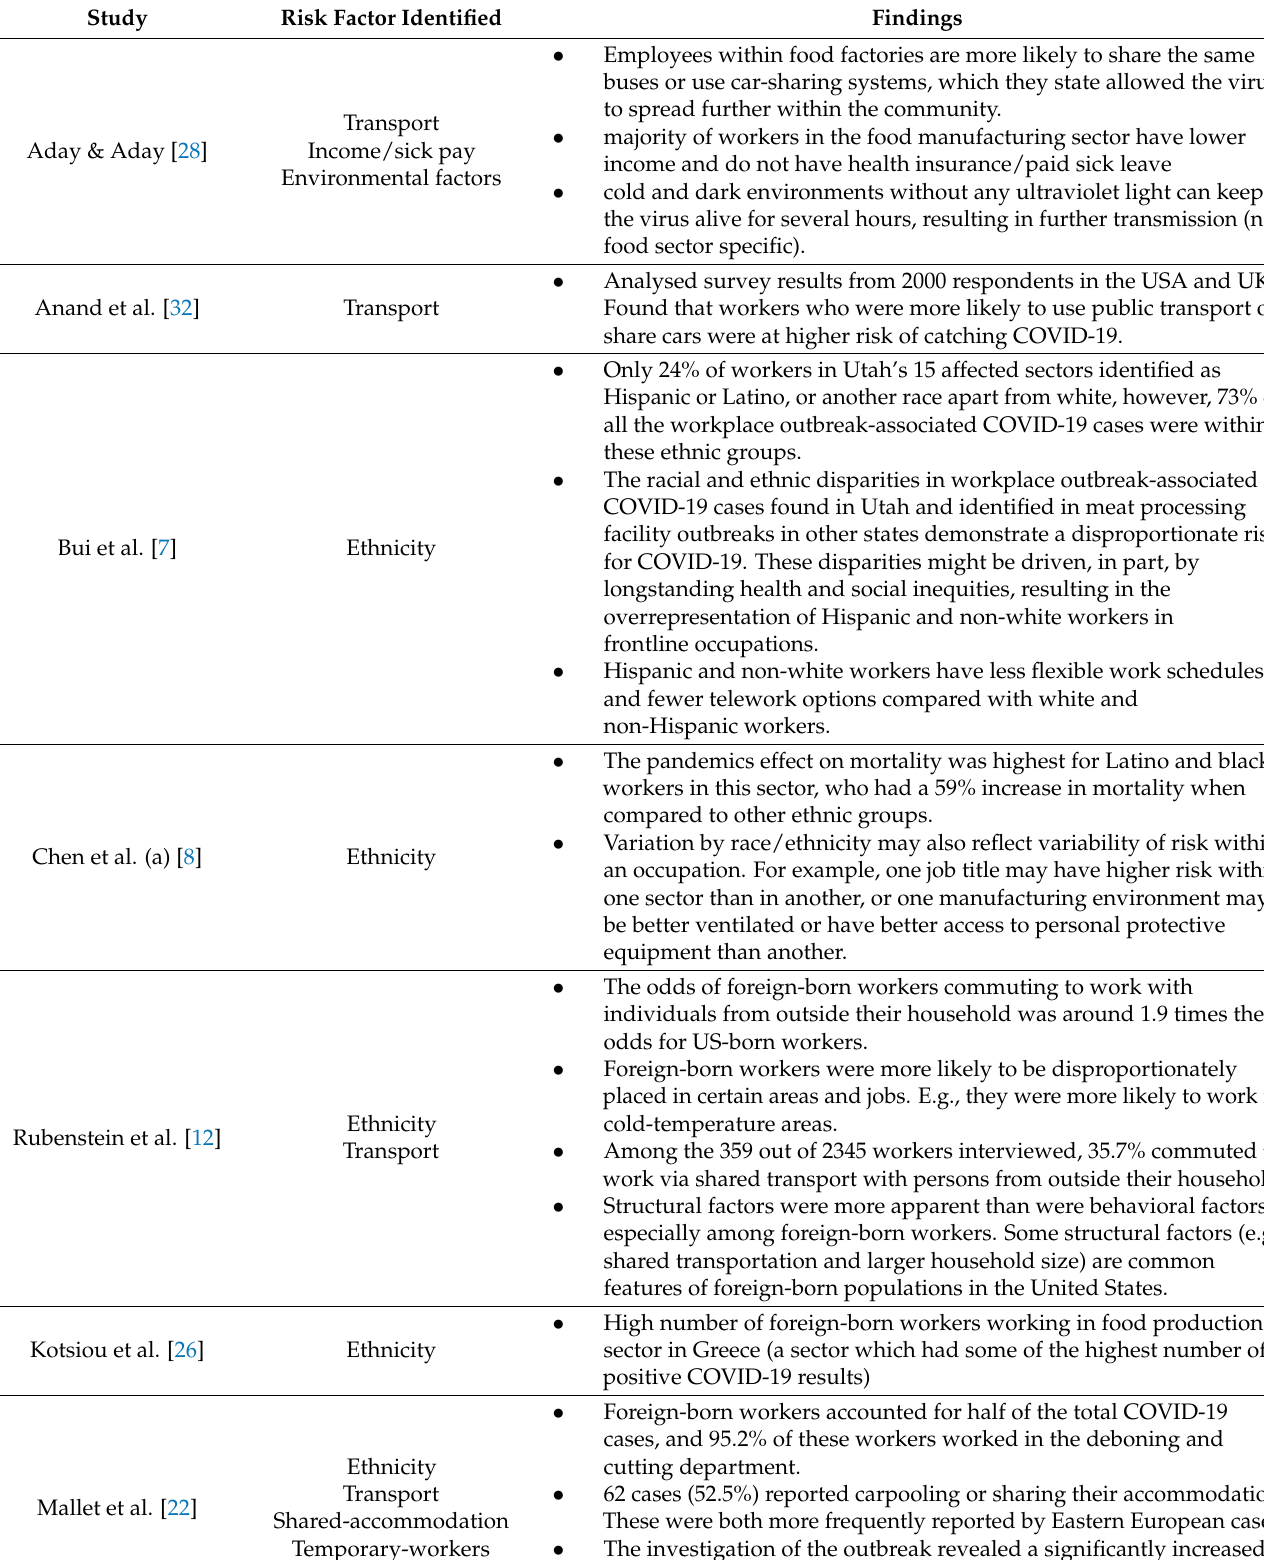
Table 3. Summary of findings on risk